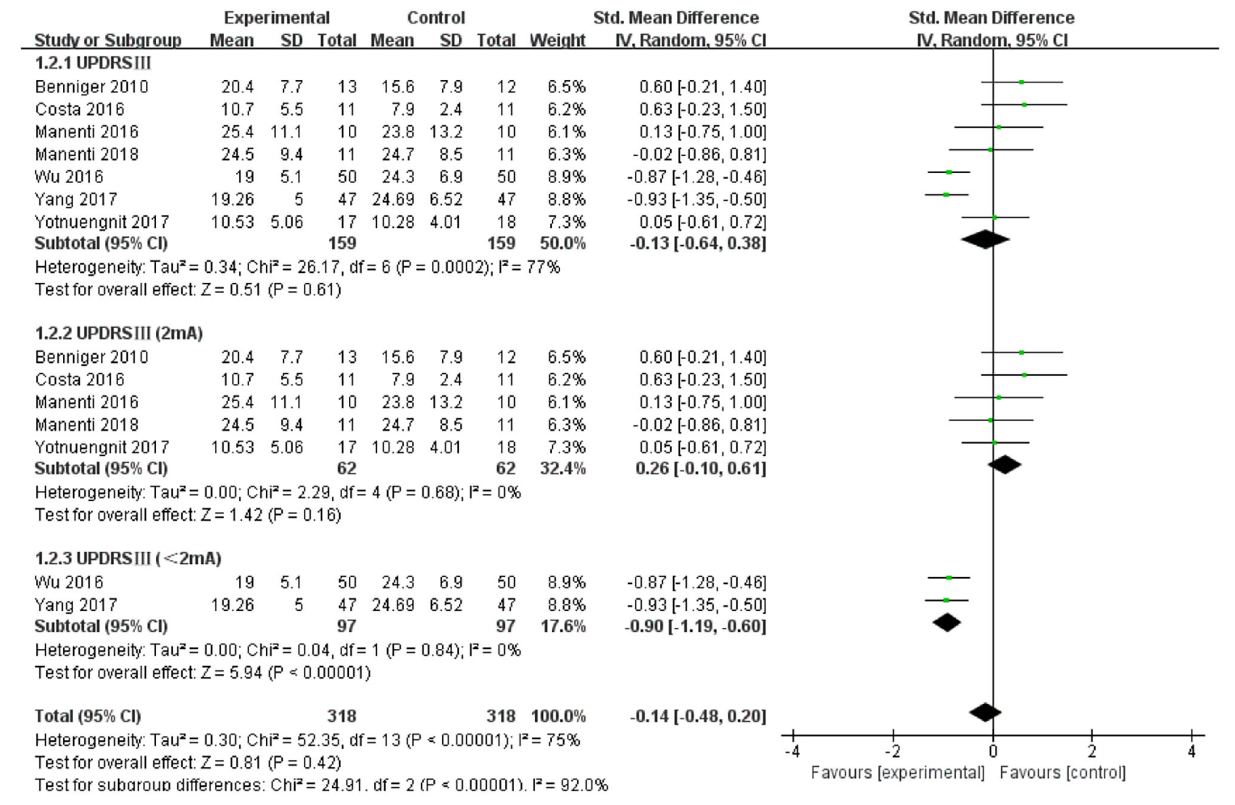
FIGURE 5 | Forest plot of UPDRS III according to the subgroup of tDCS intensity. CI, confidence intervals; SD, standard deviation; tDCS, transcranial direct current stimulation; UPDRS, Unified Parkinson’s Disease Rating